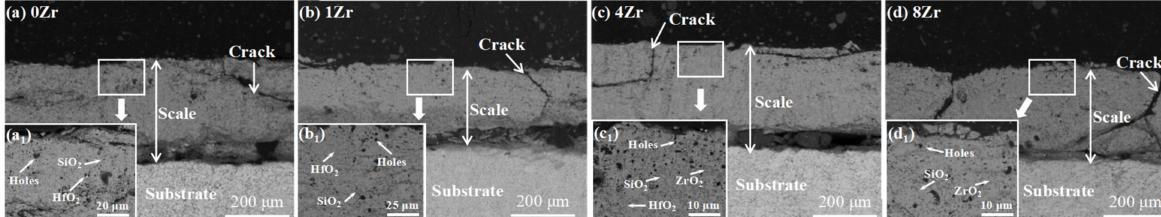
Figure 9. Cross-sectional BSE images of the Nb-22Ti-15Si-5Cr-3HF-3Al-xZr (x = 0 at.%, 1 at.%, 4 at.%, 8 at %) alloys after oxidation at 1250 ◦ C for 20 h. ( a ) 0Zr; ( b ) 1Zr; ( c ) 4Zr; ( d ) 8Zr. The a 1 , b 1 , c 1 , and d 1 are microarea images in figures ( a – d ), respectively. Copyright 2017